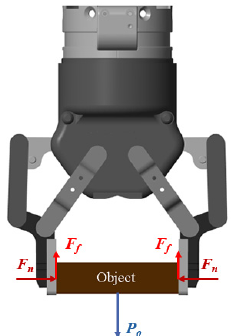
Figure 3. Force diagram of gripping and picking up the object.